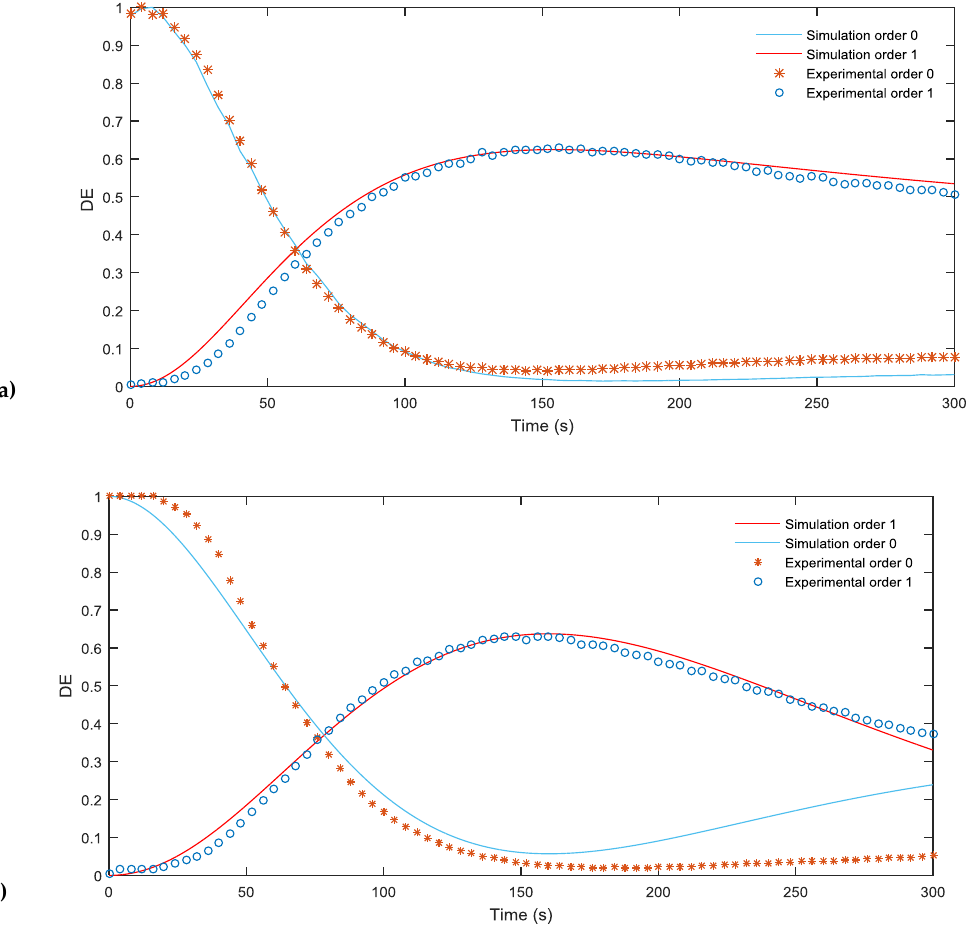
Figure 4. ( a ) Comparison of the simulated and experimental DE of a 672 µ m blazed grating during an exposure time of 300 s; ( b ) Comparison of the simulated and experimental DE of a 336 µ m blazed grating during an exposure time of 300 s.